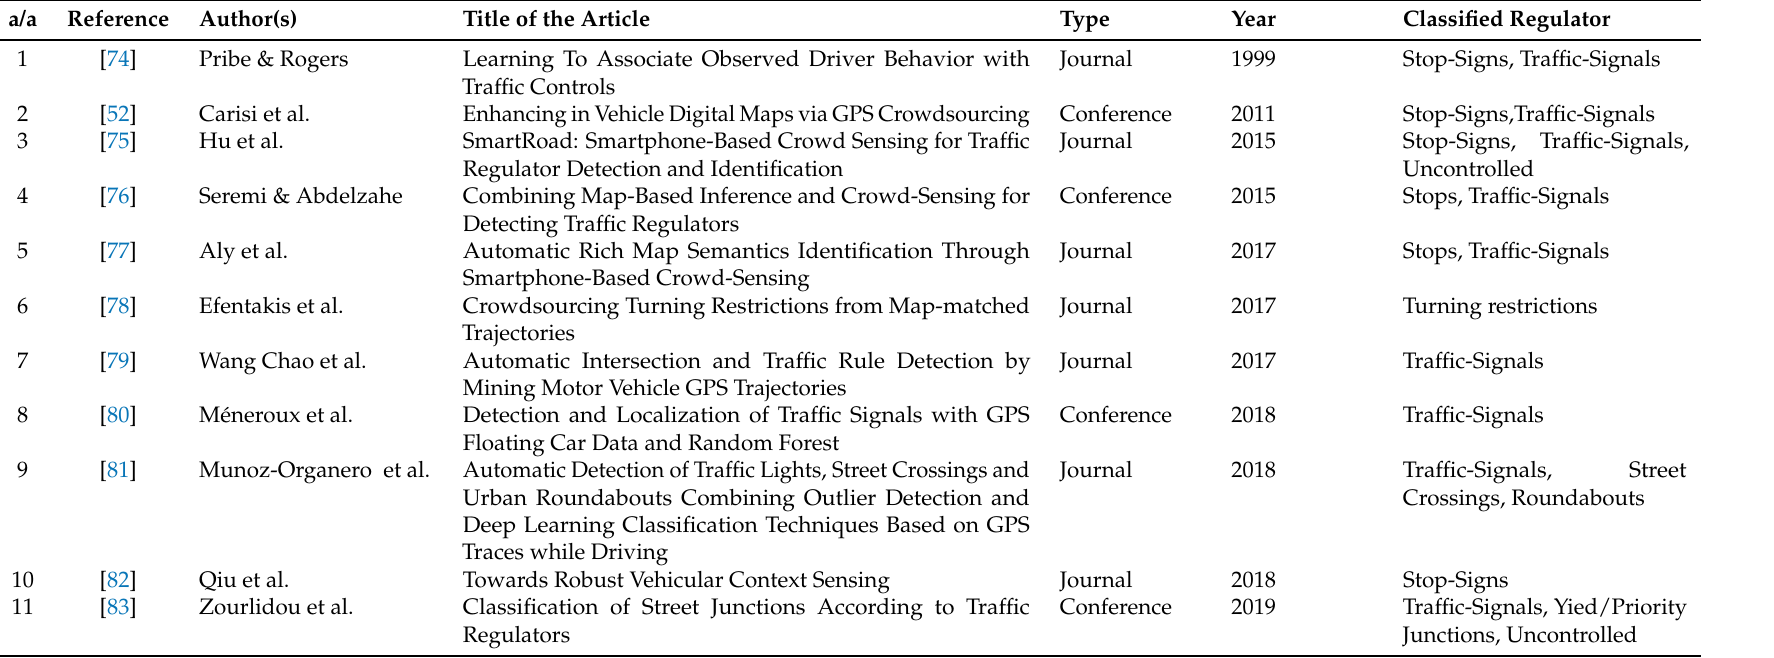
Table 8. Articles selected after the Screening step of the SLR process in chronological